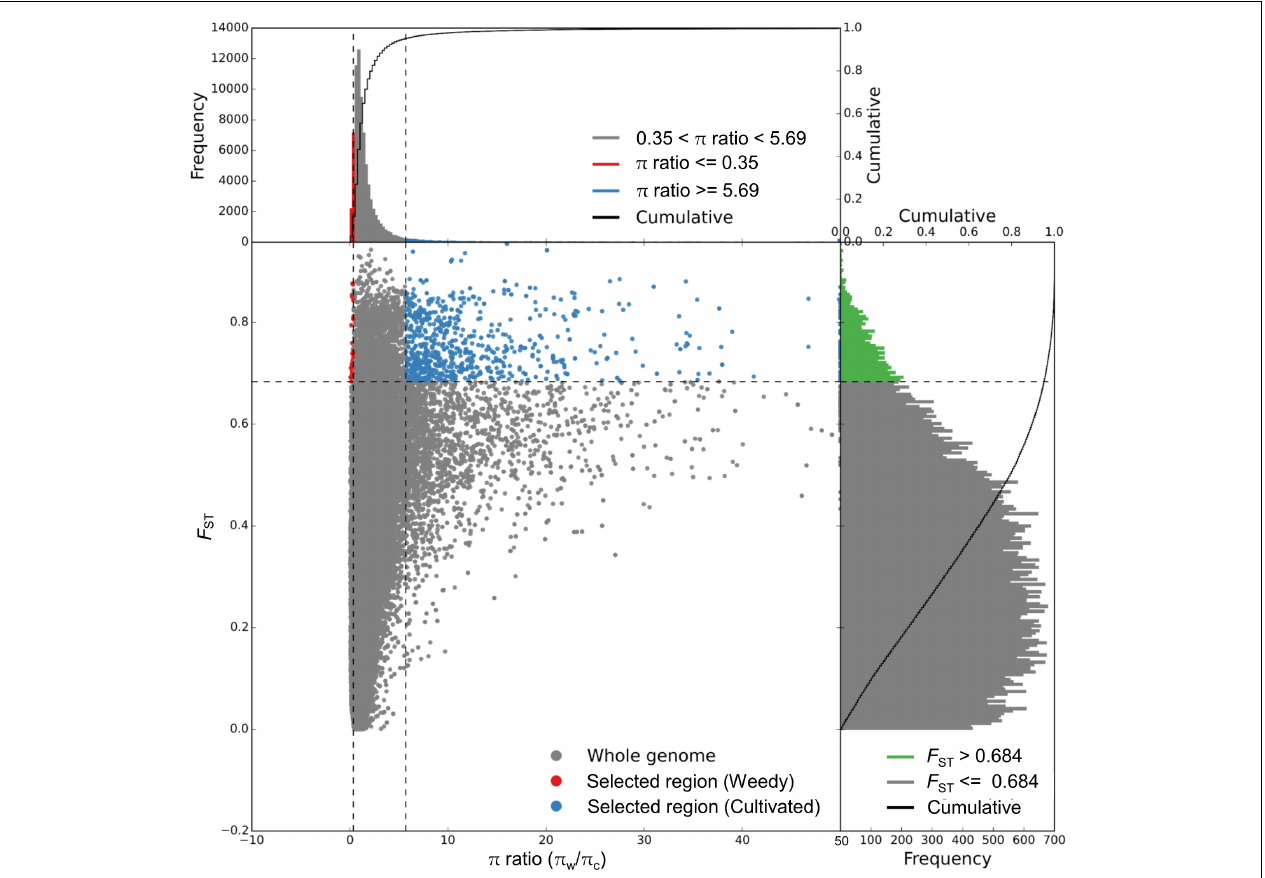
FIGURE 4 | Genomic regions with selective sweep signals in cultivated broomcorn millet genome showing distribution of π ratio ( π w / π c ) and F ST values of 100-kb windows with 10-kb steps. Blue dots represent windows fulfilling the requirement (i.e., F ST ≥ 0.684 and π ratio ≥ 5.69) of selected regions in genome of cultivated broomcorn